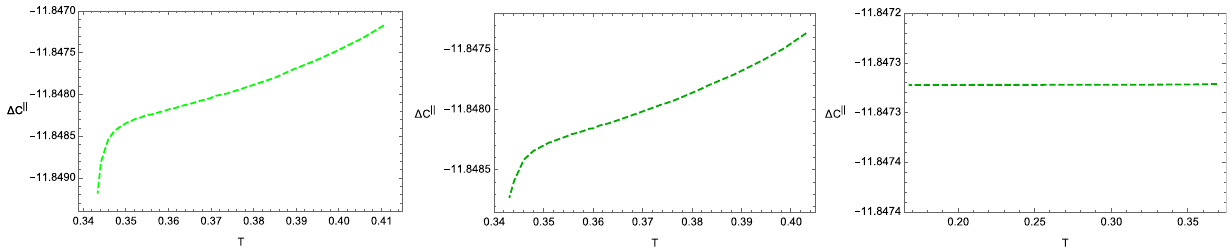
Fig. 7 In all three panels l = 0 . 5 and in the isotropic case ν = 1 and in the anisotropic case ν = 1 . 01. (cid:6) C || as a function of T at μ = 0 for the stable branch, that is large black holes ones (left). (cid:6) C || as a function